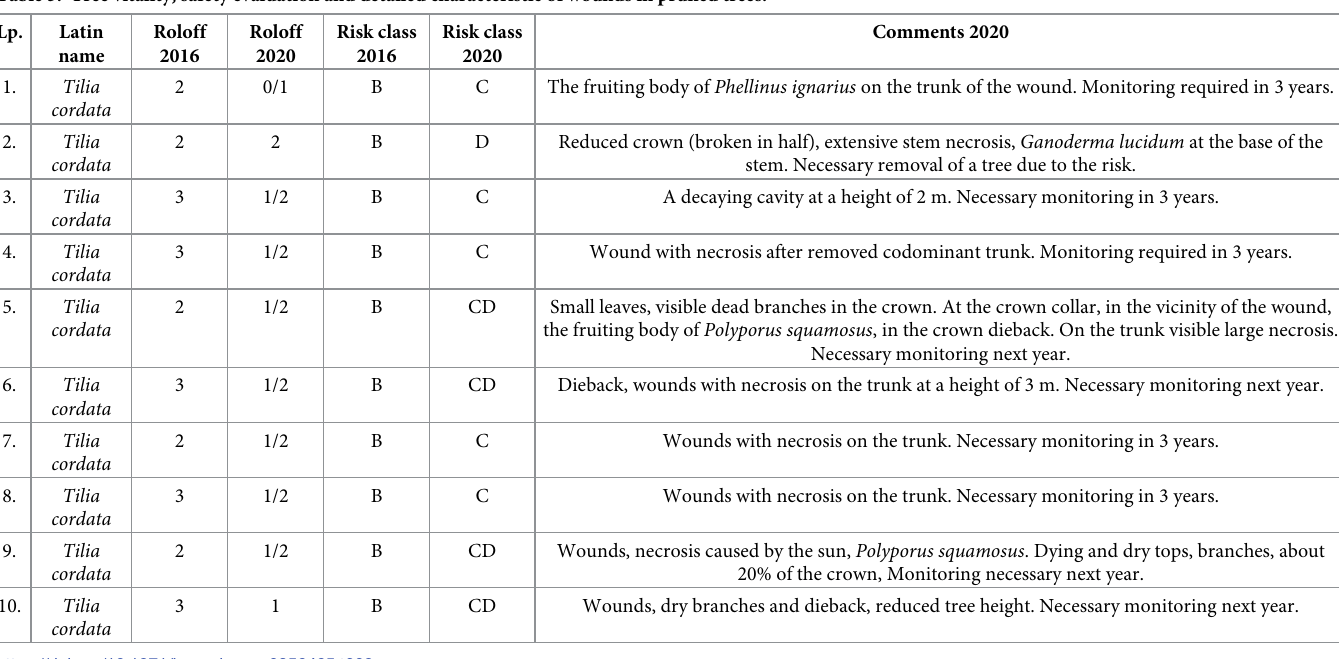
Table 3. Tree vitality, safety evaluation and detailed characteristic of wounds in pruned trees. Lp.